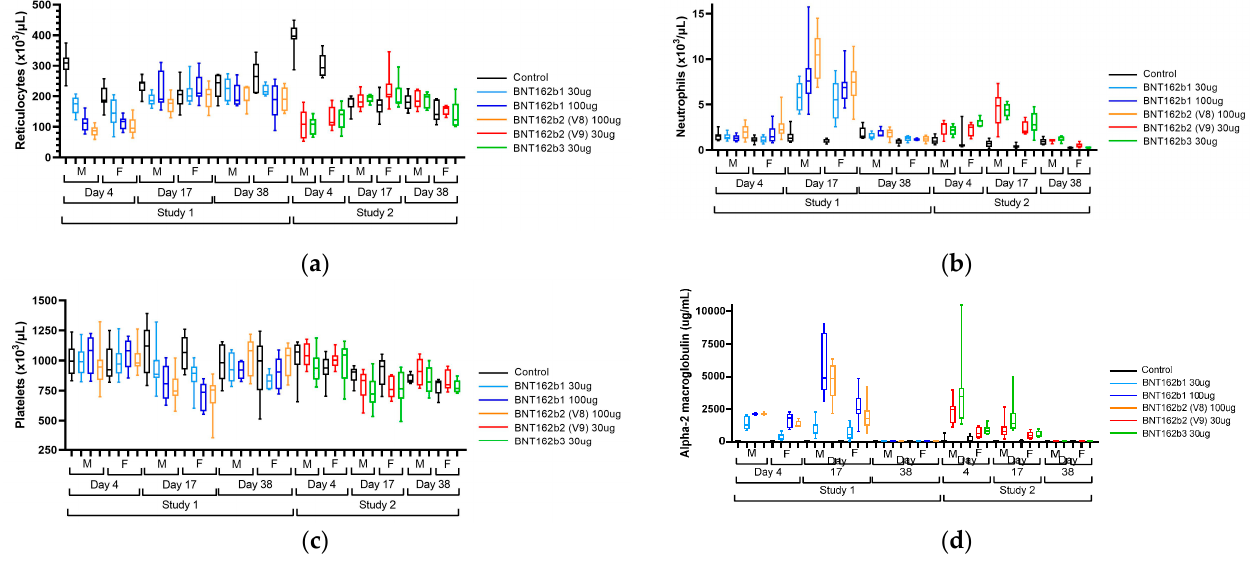
Figure 4. Reticulocyte counts ( a ), neutrophil counts ( b ), platelet counts ( c ), and alpha-2 macroglobulin ( d ) concentrations in male (M) and female (F) Wistar Han rats immunized intramuscularly (IM) with BNT162b1 (30 µg or 100 µg), BNT162b2 V8 (100 µg), BNT162b2 V9 (30 µg), BNT162b3 (30 µg), or buffer control. Blood samples were collected on Dosing Phase Days 4, 17, and 38. Box-whisker plots show group medians (middle line), 25th and 75th percentiles (box), and min and max (lower and upper